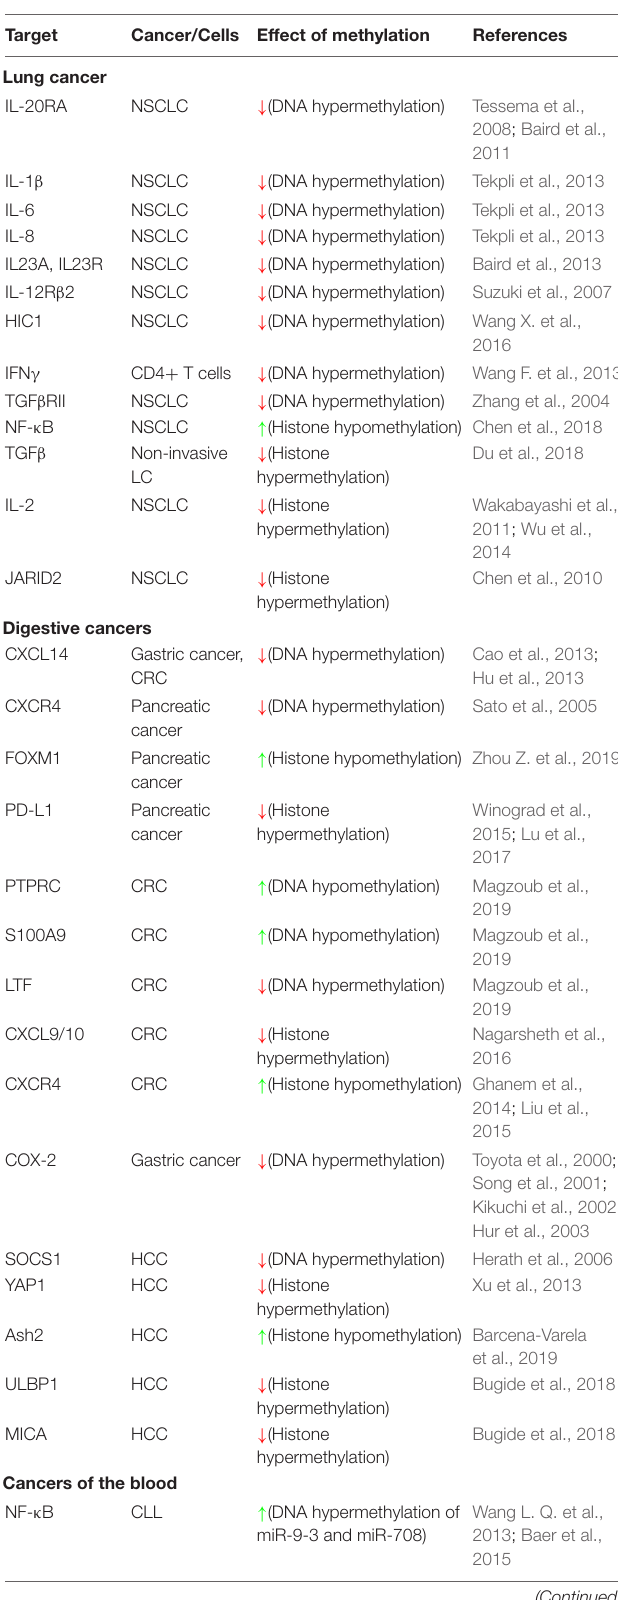
TABLE 1 | DNA and histone methylation in regulation of inflammatory signaling